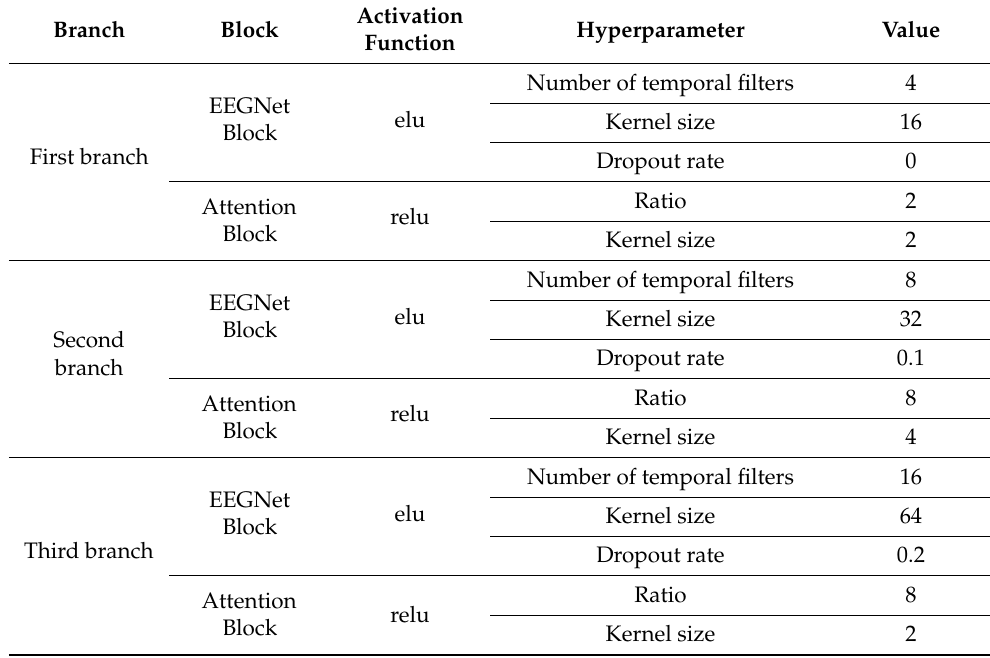
Table 1. Global hyper-parameters used in proposed